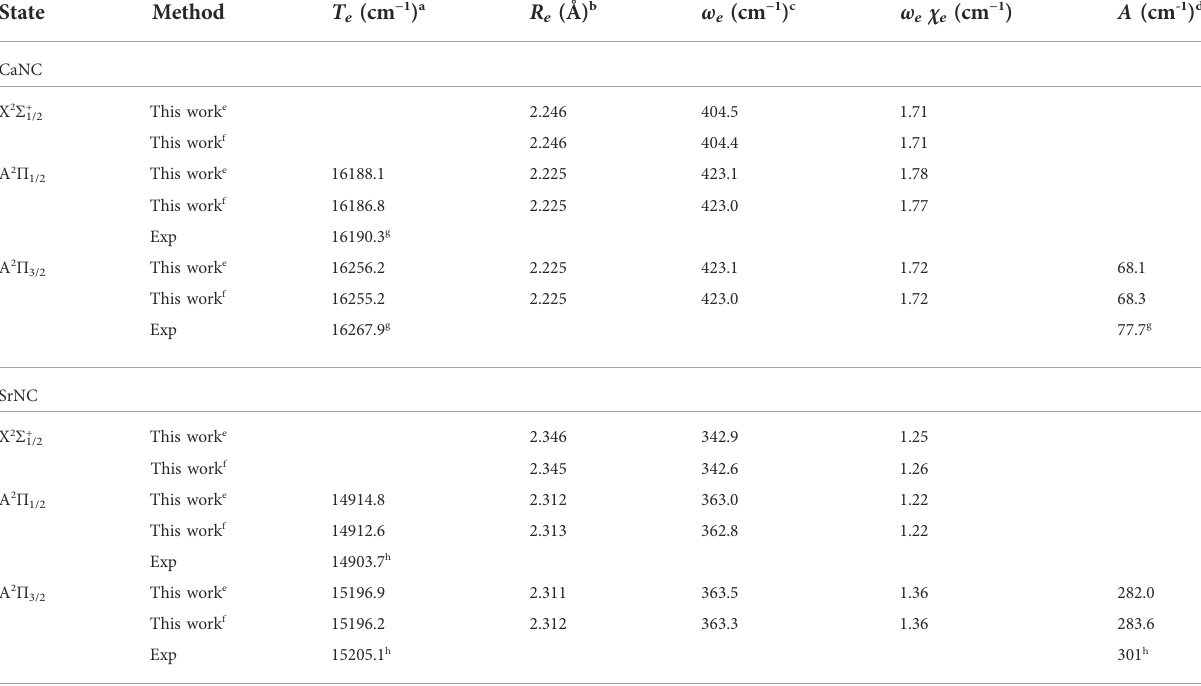
TABLE 2 The calculated spectroscopic constants of several Ω states of CaNC and SrNC.